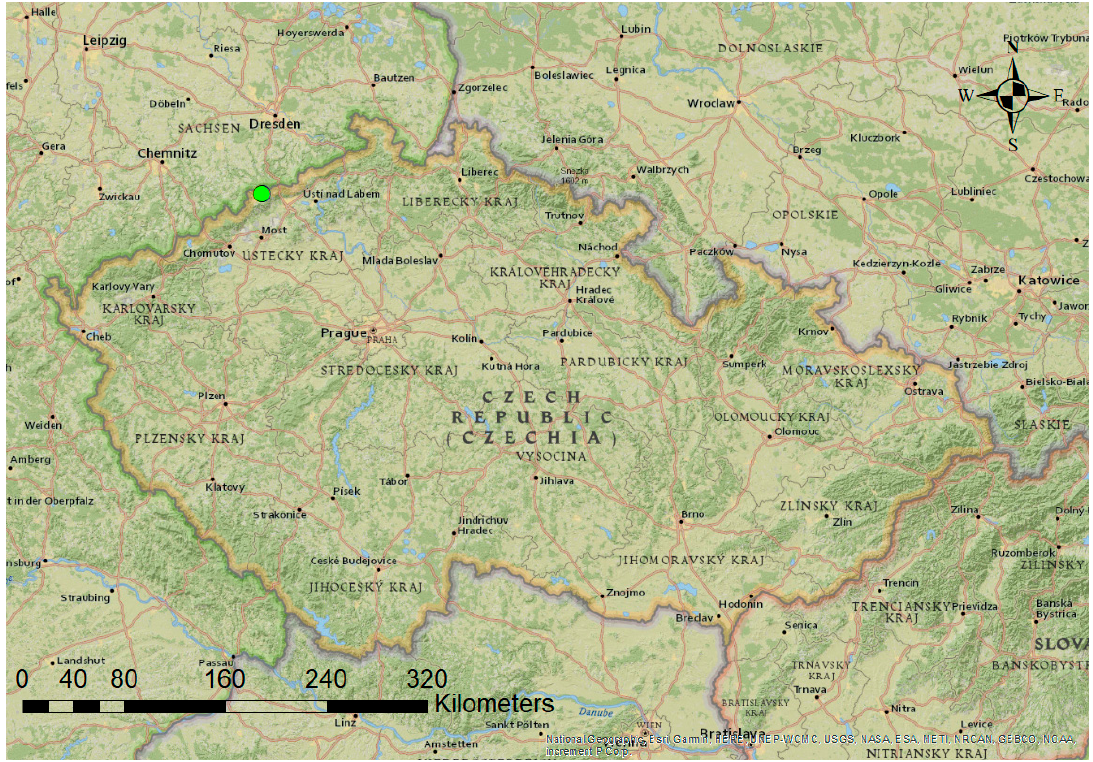
Figure 1. Location of the research plot in the northern region of the Czech Republic. The plot is marked with green point.